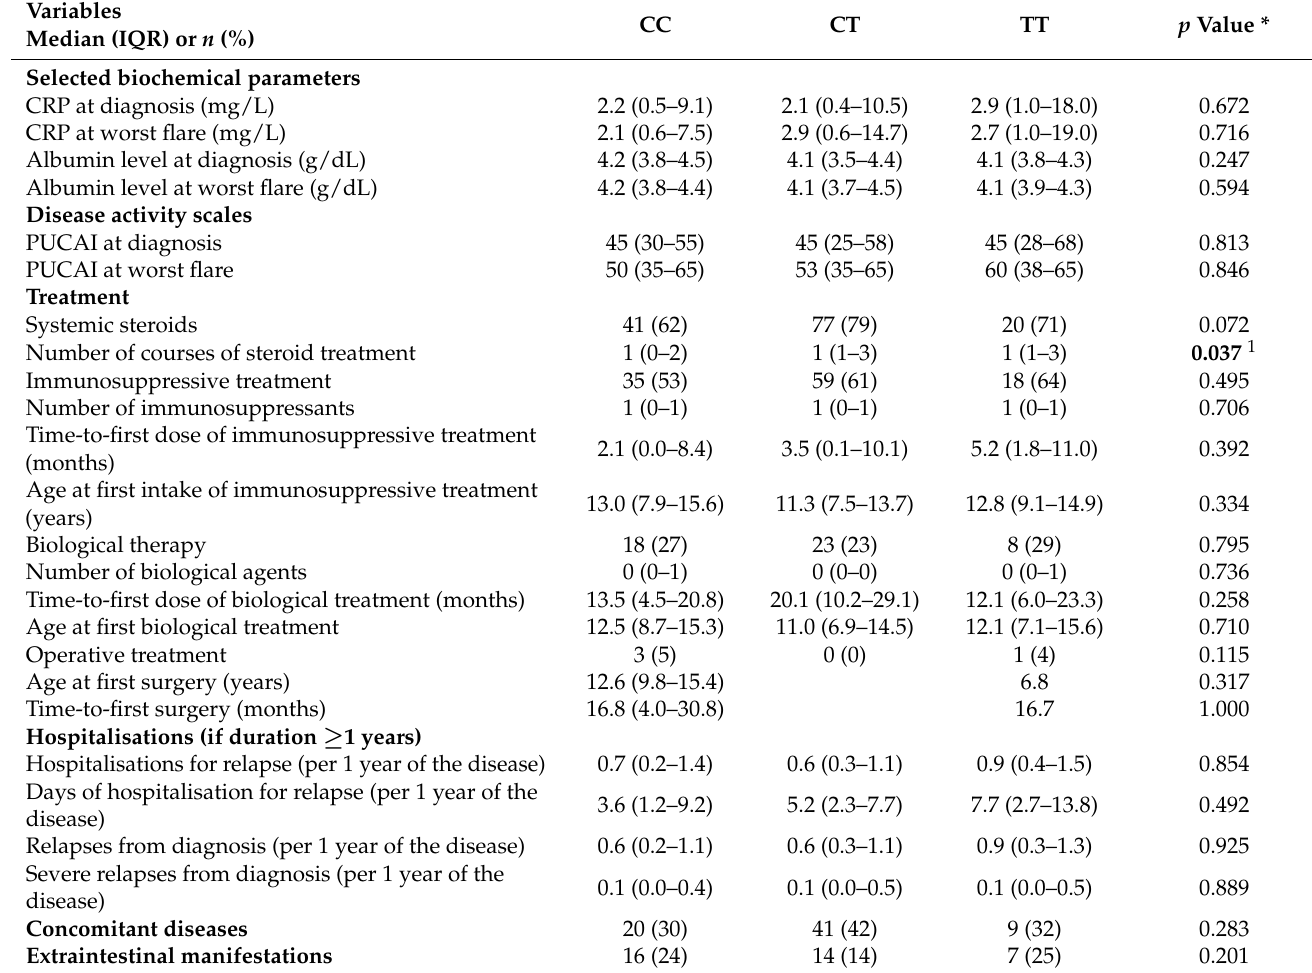
Table 6. Association between SFTPD rs2243639 genotypes and UC